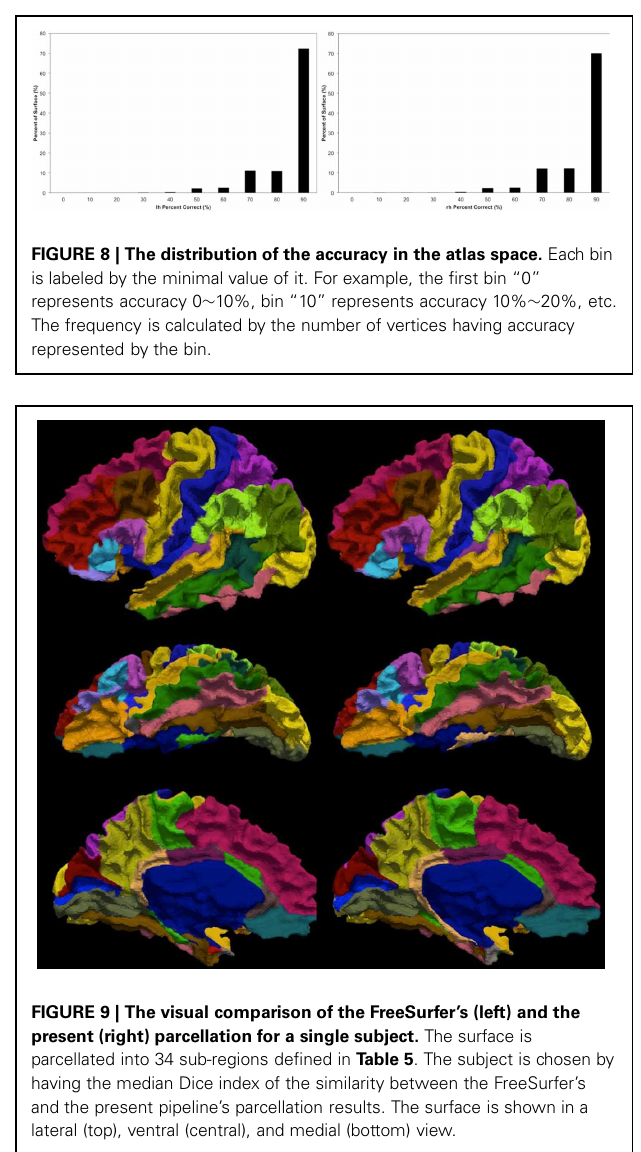
lower. In addition, we have presented the Dice coefficient for